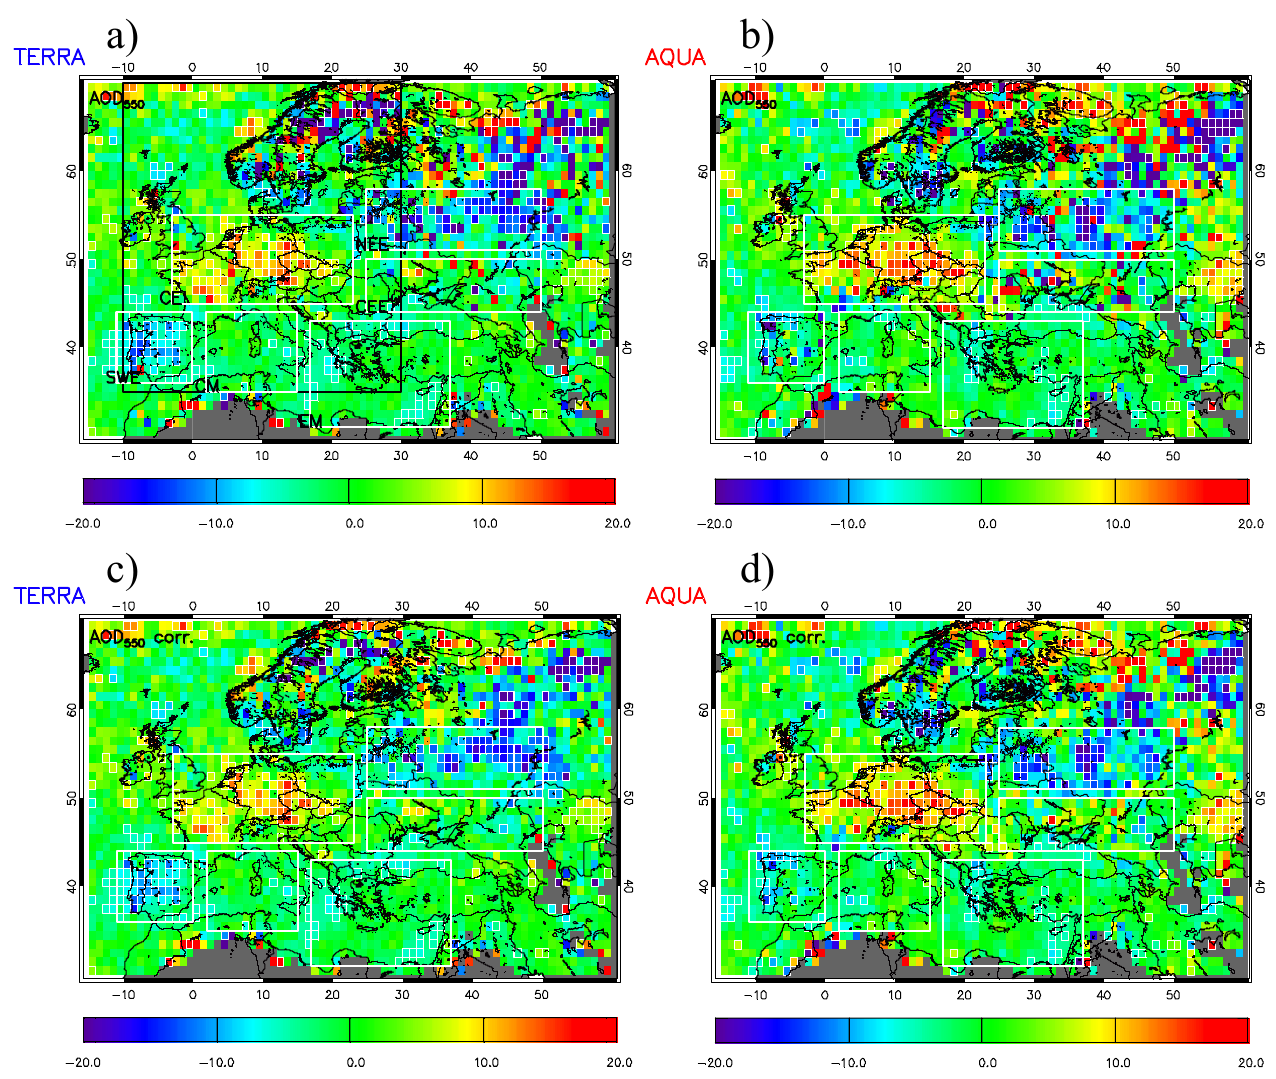
Fig. 1. Left column: From TERRA MODIS data for the period February 2000–February 2009. Right column: AQUA MODIS data for the period July 2002–December 2008. (a, b) WCI patterns calculated from AOD 550 measurements, (c, d) the same as (a, b) but for data corrected with the ± 1000% limit. The grid cells with a statistically significant value at the 90% confidence level according to the two tailed t-test appear with a thin white outline. The six regions of interest are marked with a thick white outline in all the maps. The region examined in Quaas et al. (2009) (QE) is marked with a thick black line in Fig. 1a only. See also